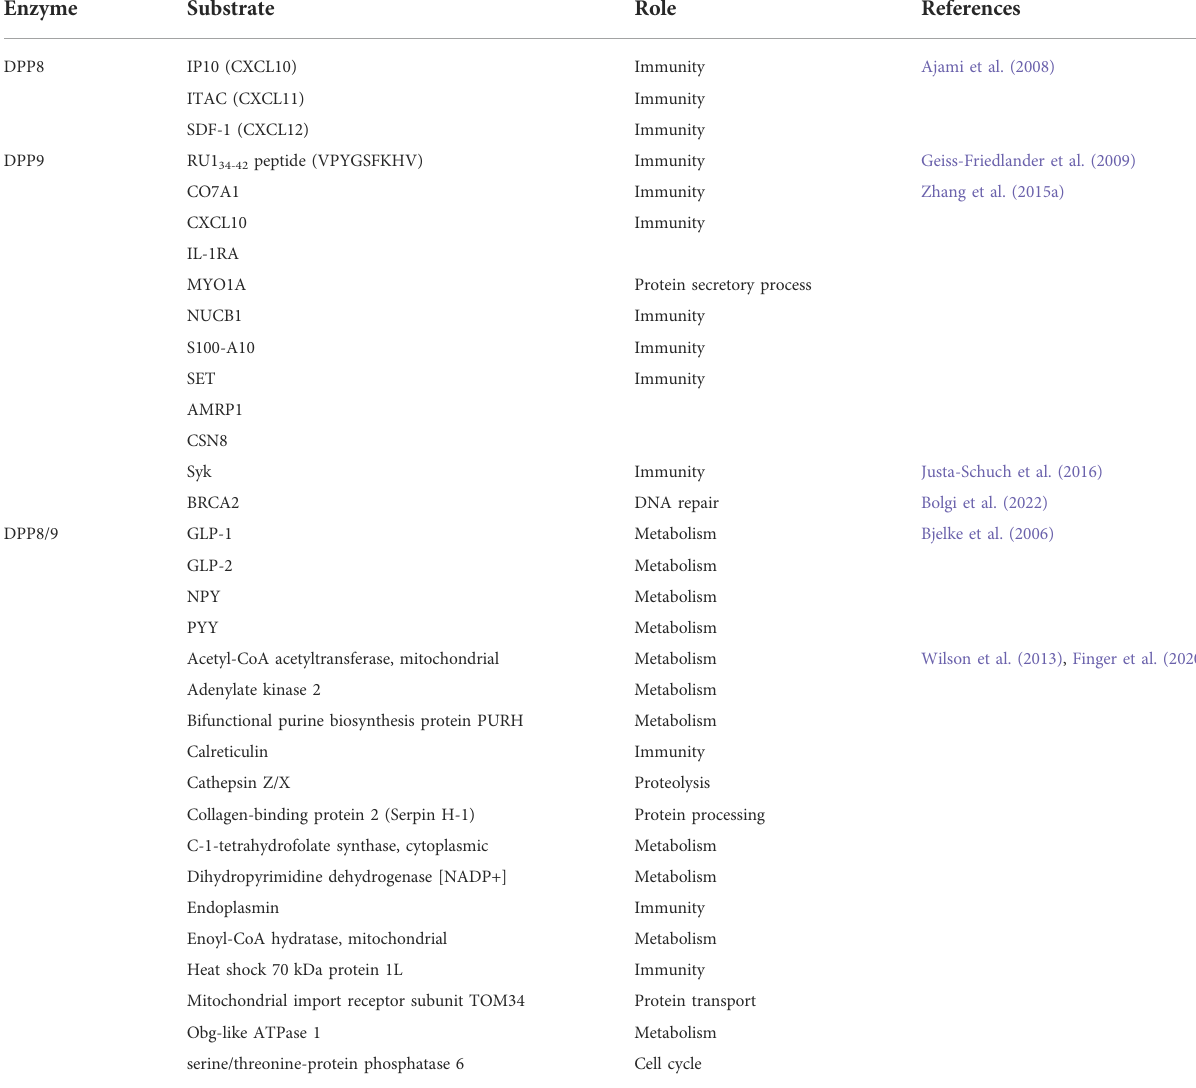
TABLE 1 Roles of DPP8/9 substrates.